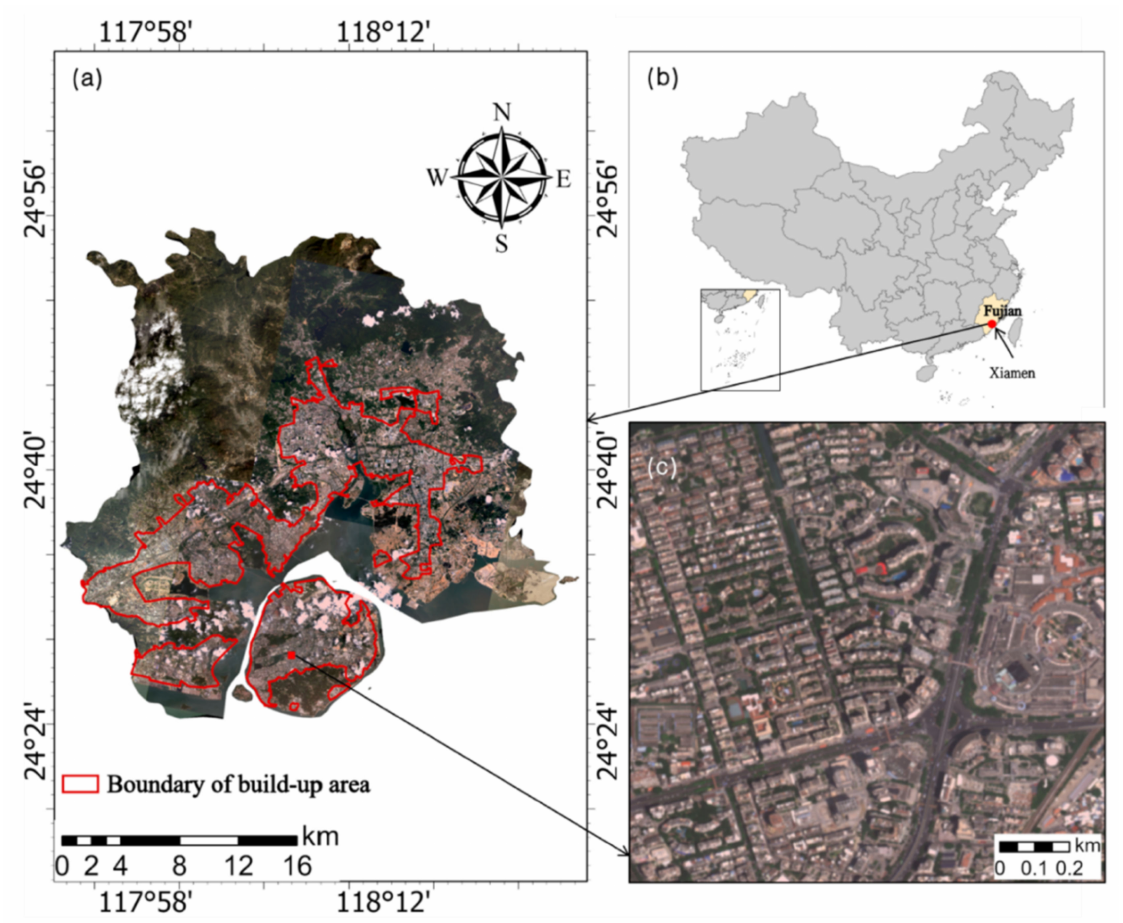
Figure 1. ( a ) Gaofen-7 image of Xiamen; ( b ) Xiamen location; and ( c ) enlarged subset of the red-frame